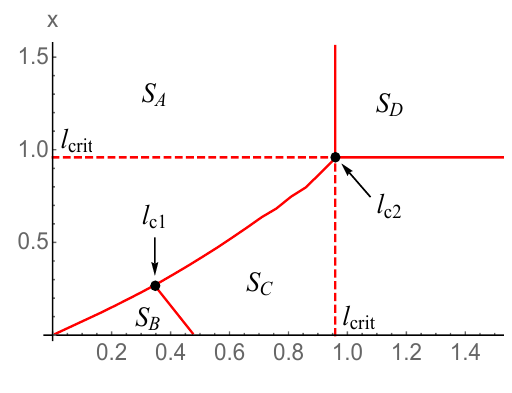
Figure 7 . The phase diagram of various entangling surfaces for the case of two strips of equal length ‘ separated by a distance x in the thermal-AdS background. The four di(cid:11)er- ent phases correspond to the four bulk surfaces of (cid:12)gure 6. ‘ c 1 and ‘ c 2 indicate two tri-critical points. The vertical and horizontal dashed lines indicate the critical length ‘ crit . In units